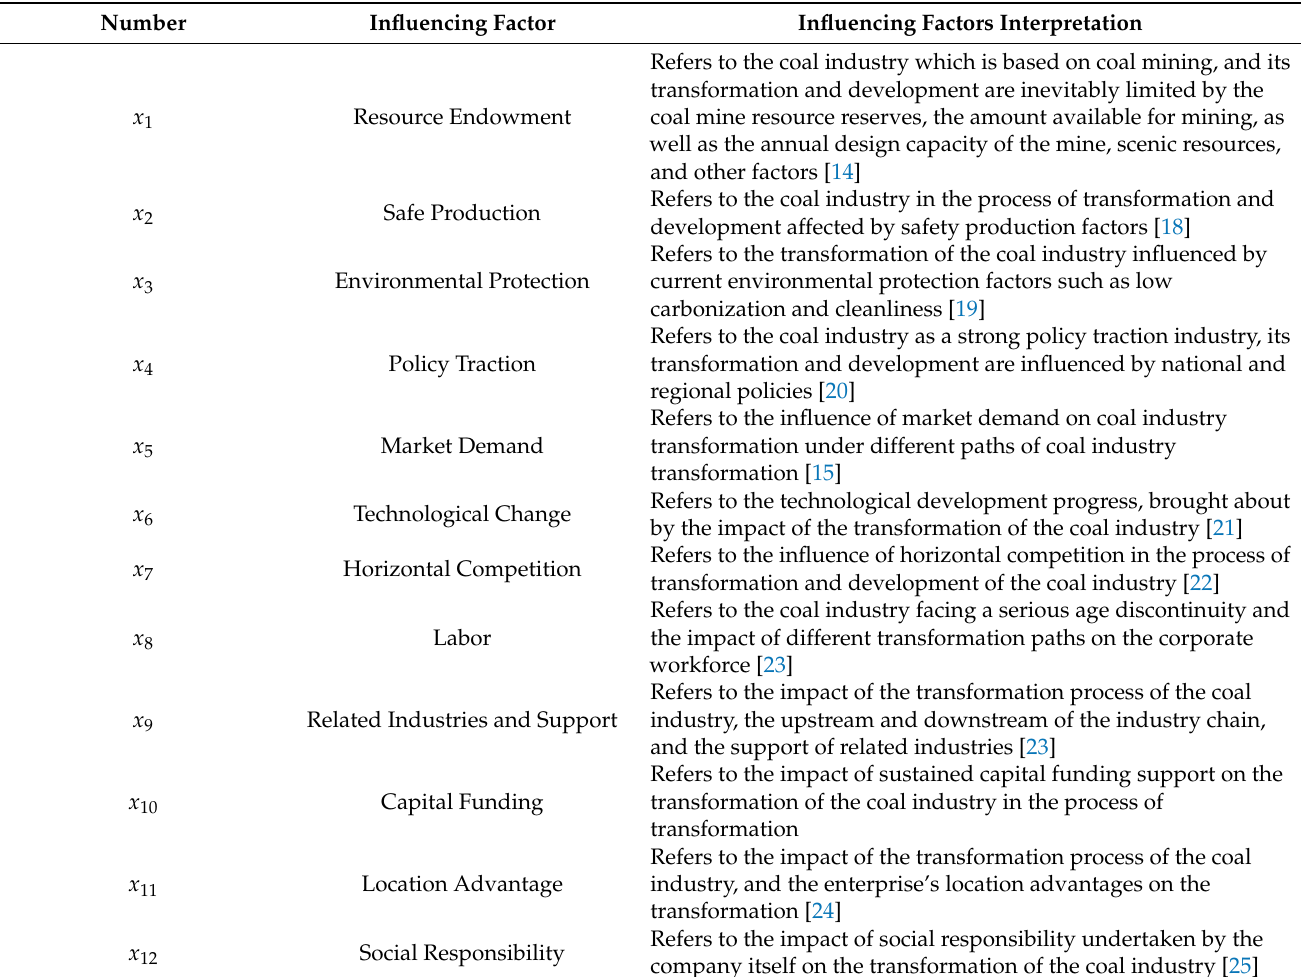
Table 1. List of factors influencing the transformation of the coal